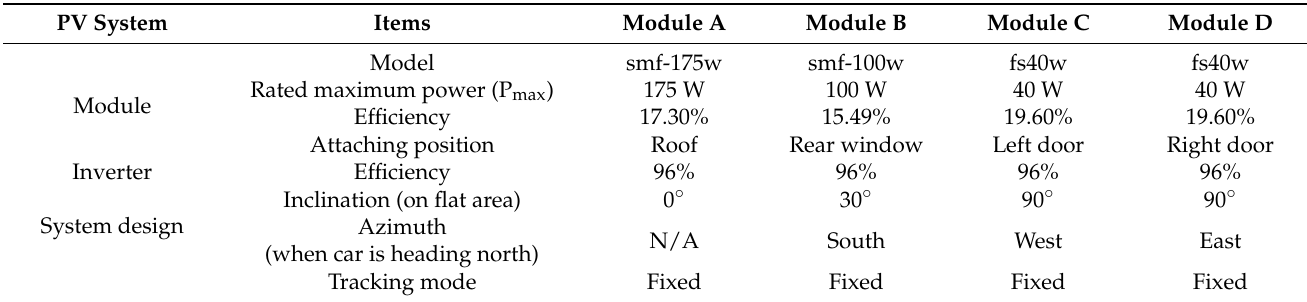
Table 2. Specifications of the PV module and inverter set to PV powered